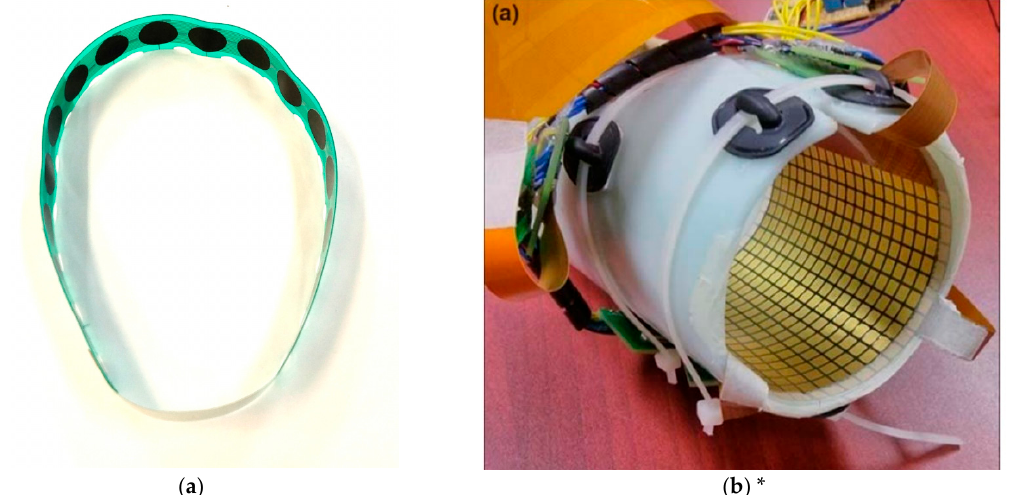
Figure 6. An example of a force sensing array and a matrix. ( a ) Force sensing array ( b ) Force sensing matrix. (* reproduced with permission from Radmand et al.